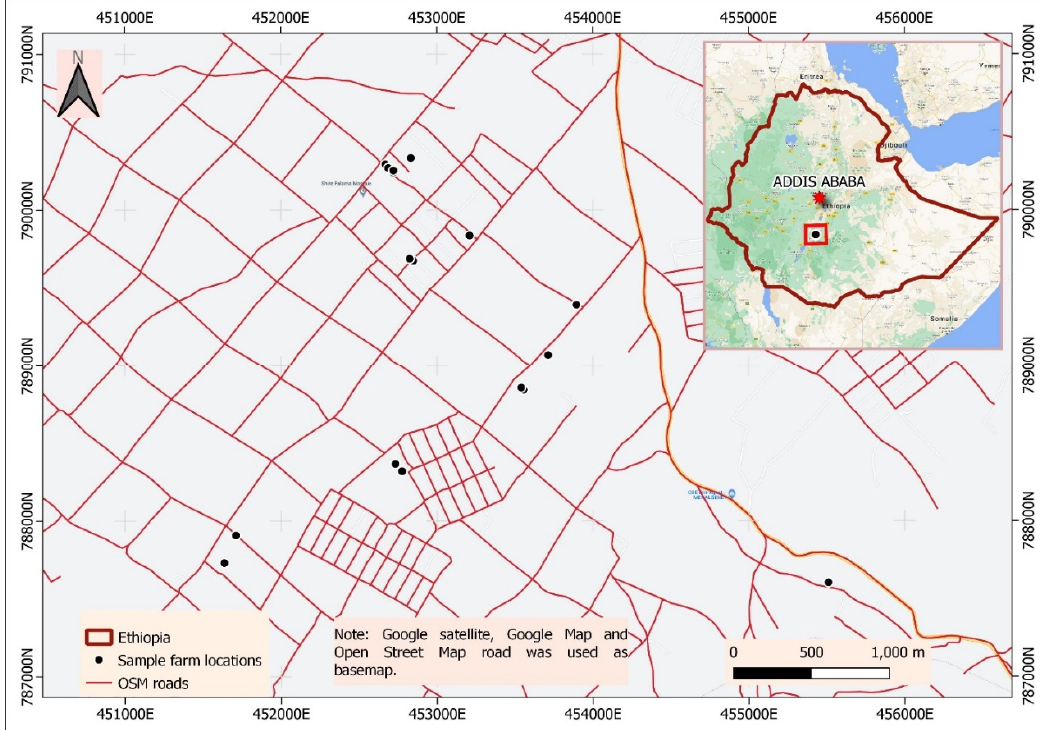
Figure 1. Map of the study area, showing the studied smallholder farmers’ fields (black dots) at Wondo District, Oromia Region, Southern Ethiopia (map provided by M. Gebrehiwot on the basis of Google Earth, Google Maps, and Open Street Map) OSM = Open Street Map.